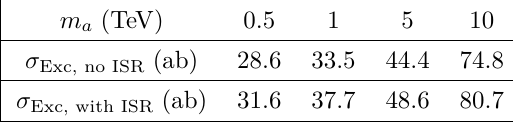
Table 5 . Exclusion limit at 2 σ level for the tri-photon search at a 14-TeV muon collider with 10 ab − 1 data.